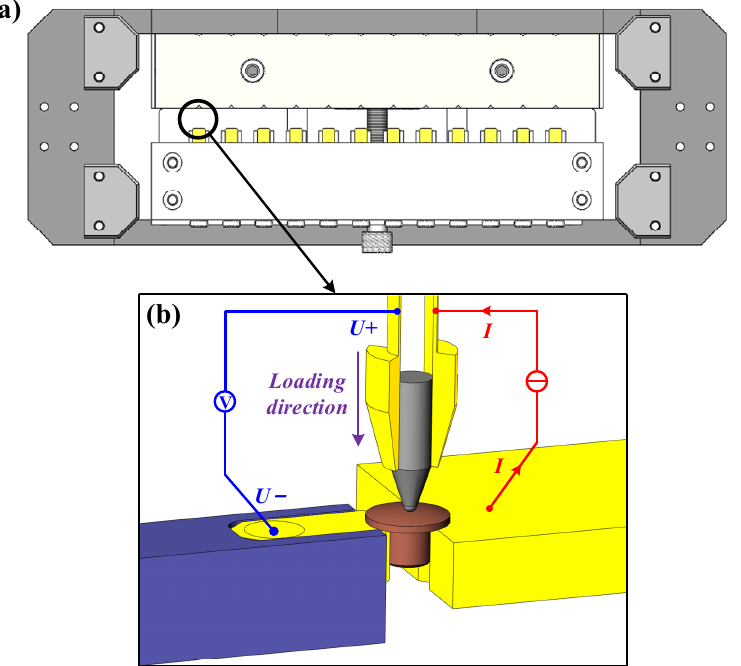
Figure 3. The schematic diagram of the clamping electrode sample. ( a ) The top view of the sample holder. ( b ) The four-wire configuration in one measurement workstation.